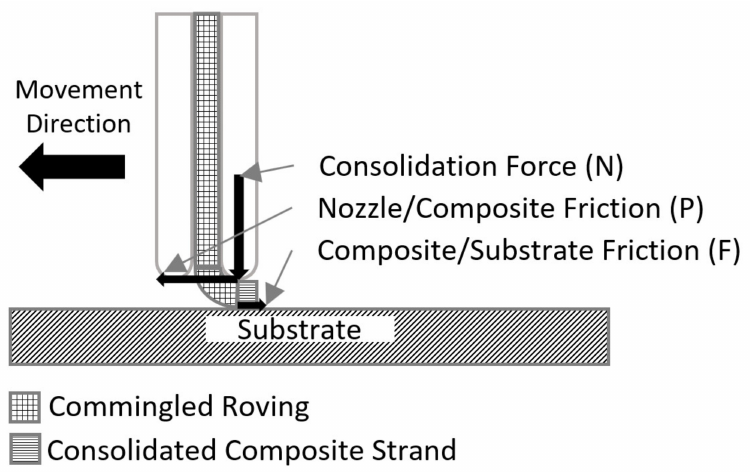
Figure 3. Forces involved in fiber